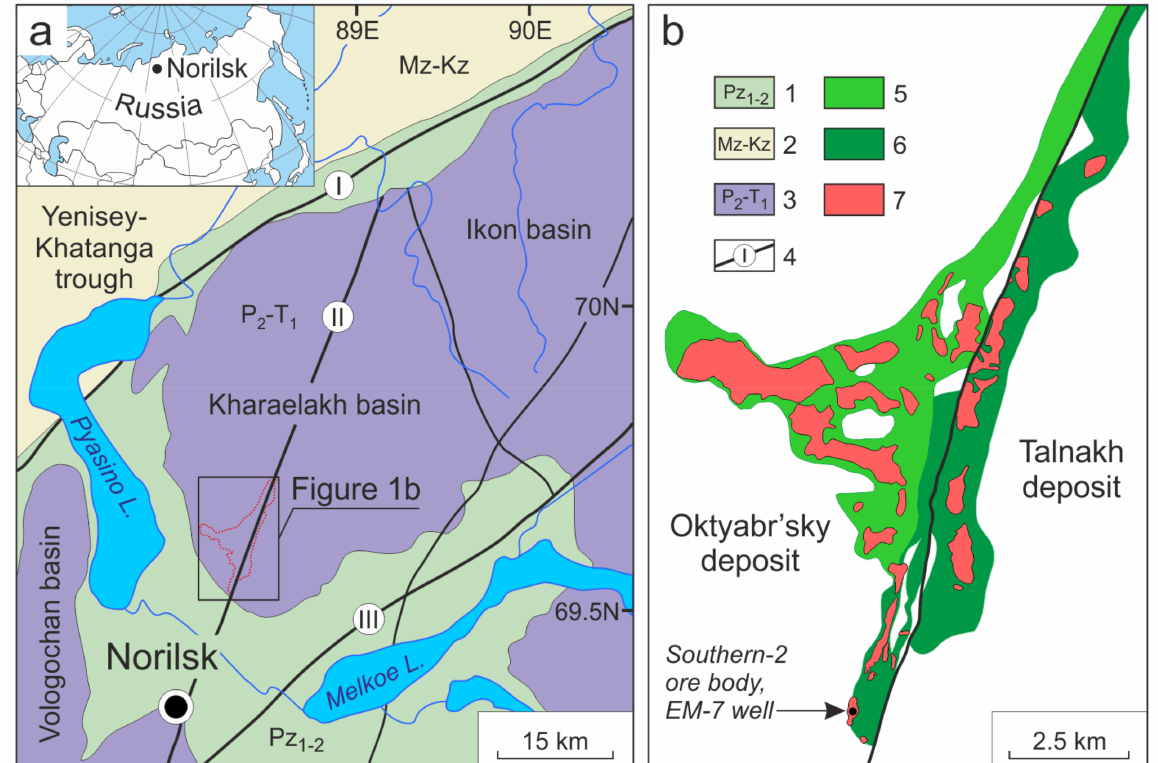
Figure 1. Location of the Talnakh ore cluster and details of its geological structure: ( a ) Geological scheme of the northern part of the Norilsk region; ( b ) Geological scheme of the Talnakh ore cluster. 1—Lower and middle Paleozoic sediments; 2—Mesozoic and Cenozoic sediments; 3—Permo − Triassic volcanics; 4—Faults: I—North Kharaelakh fault; II—Norilsk– Kharaelakh fault; III—Mikchangda fault; 5—Outline projection of the main body of the Kharaelakh ore-bearing intrusion; 6—Outline projection of the main body of the Talnakh ore-bearing intrusion; 7—Outline projection of the massive sulfide ore